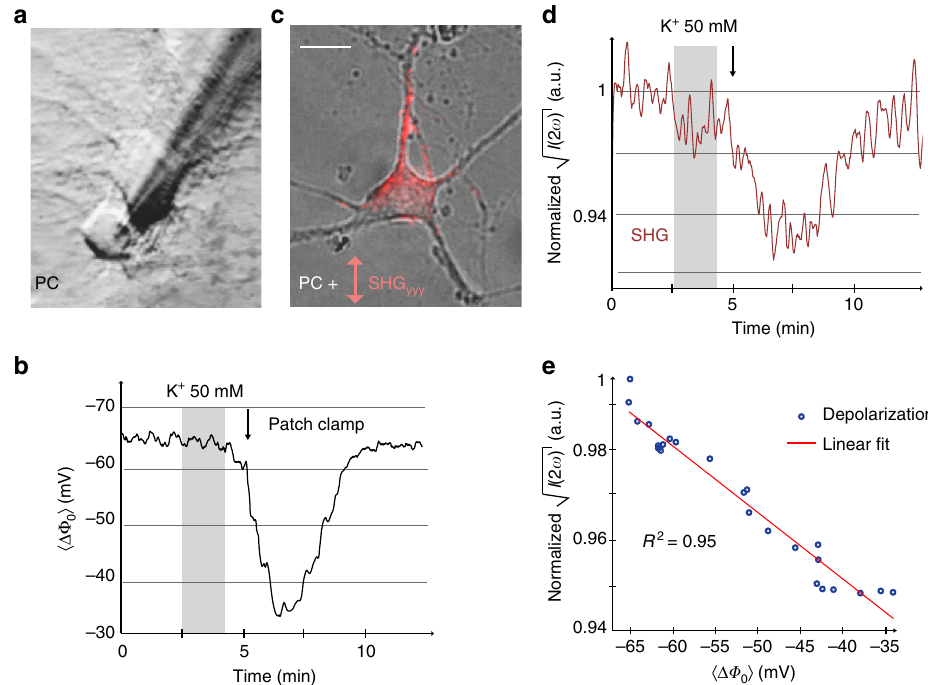
Fig. 2 Second harmonic and electrophysiological response during K + -induced depolarization. a Primary cortical neurons in culture undergoing a K + depolarization, patched ( a , b ) and probed with second harmonic generation (SHG) ( c , d ). b Whole-cell current clamp potential recording, the gray shadow area represents the time lapse application of K + solution and the arrow shows when the neurons are undertaking the solution. c Composite image of the phase contrast (PC) and second harmonic (SH) image of a cultured neuron, scale bar 20 µ m. d The normalized square-rooted spatially averaged SH response of the single neuron depicted in b . The square-rooted spatially averaged SH intensity follows the temporal trend of the patch-clamp experiment. e Linear correspondence between the changes of the square-rooted SHG intensity and the membrane potential from patch-clamp